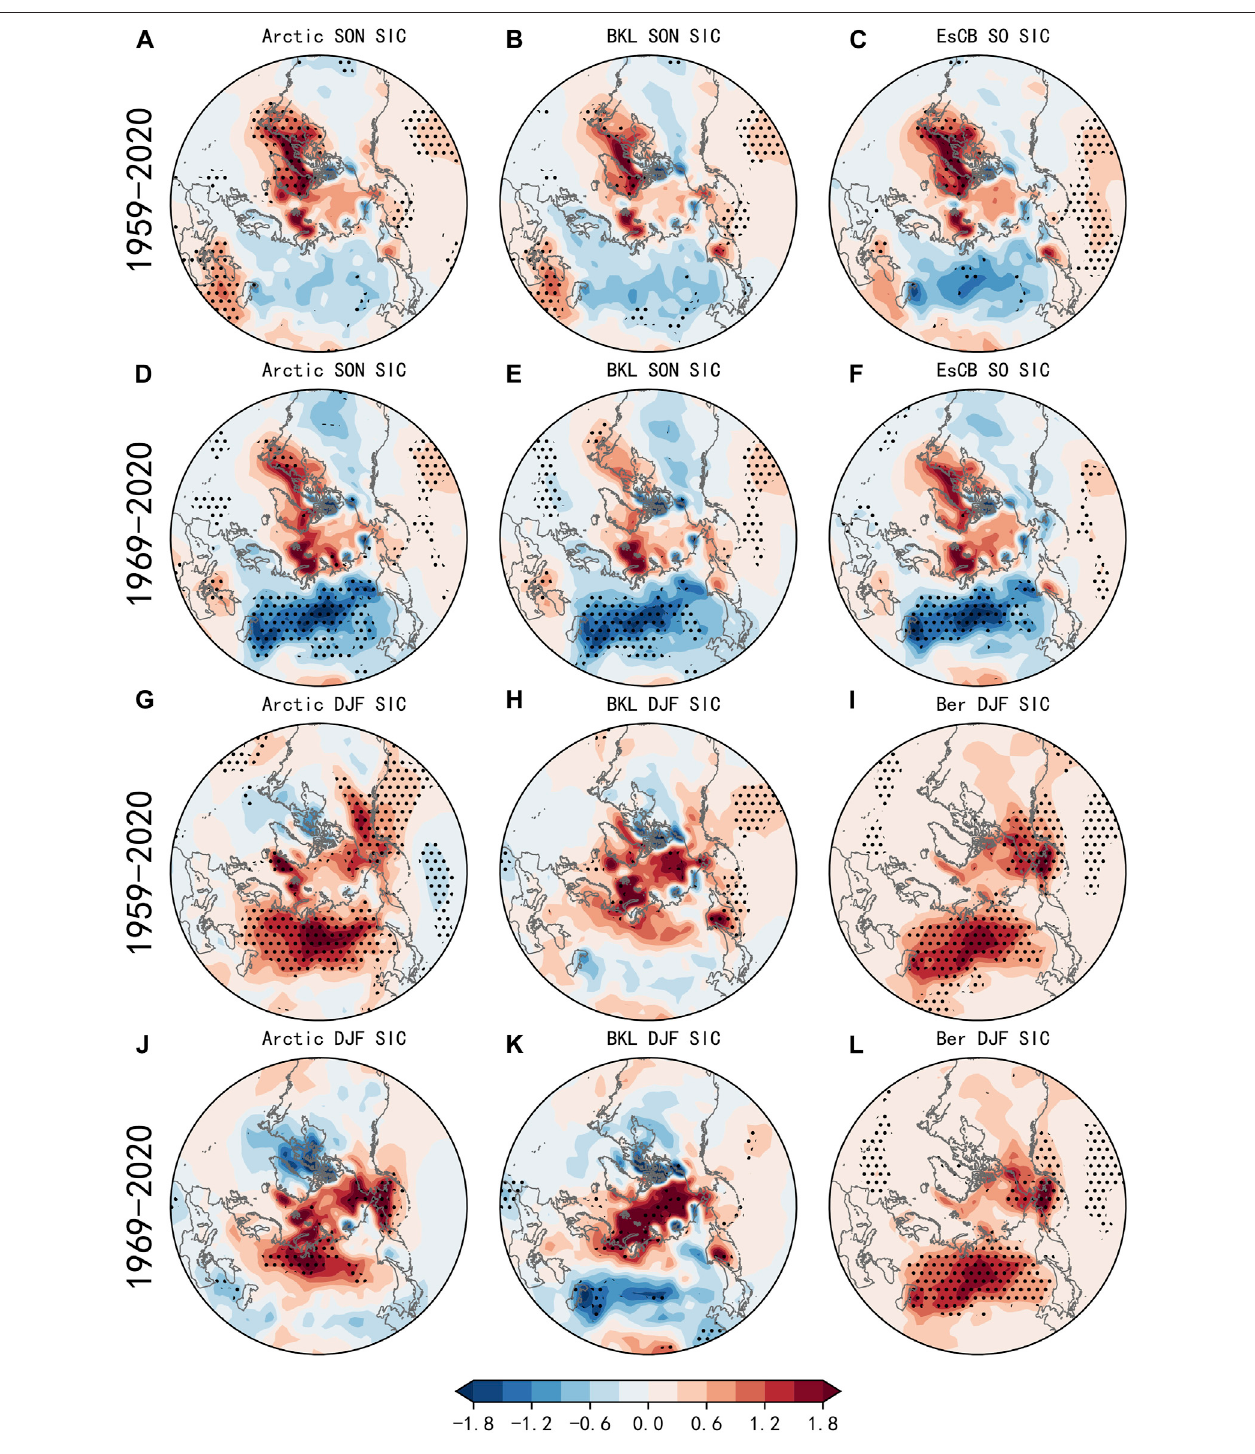
FIGURE 11 | As in Figure 3 but for interdecadal component of sea-ice indices and surface air temperature during 1959 – 2020 [ (A – C) and (G – I) ] and 1969 – 2020 [ (D – F) and (J – L) ].